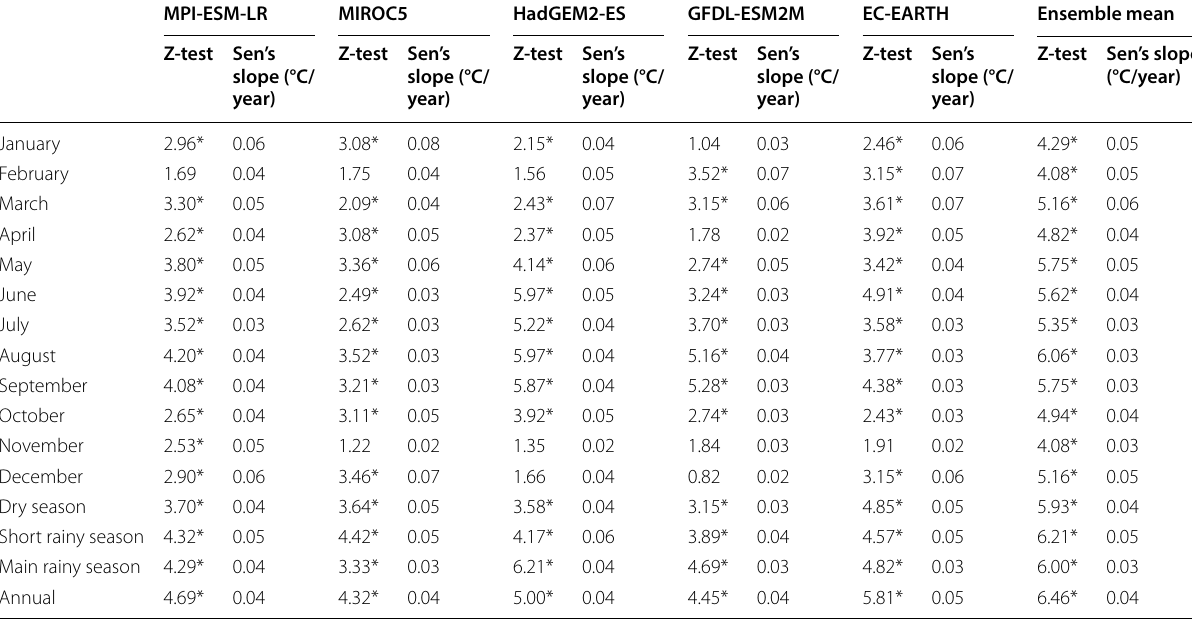
* Statistically significant at 0.05%